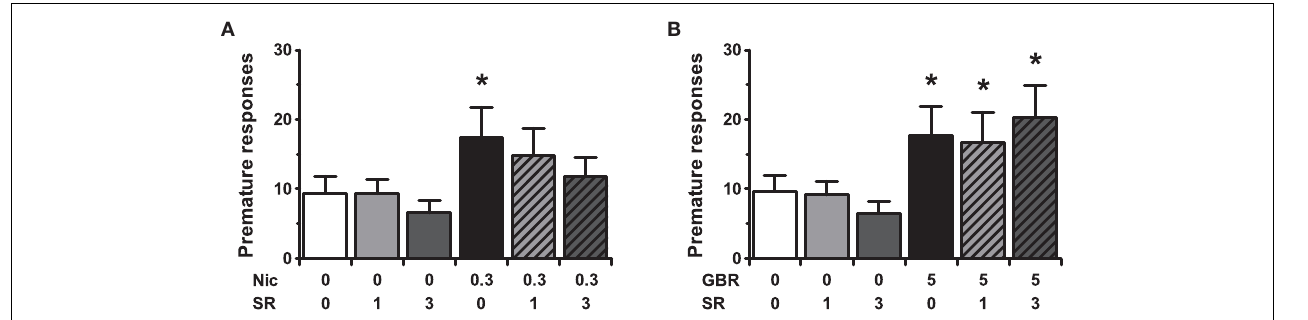
(B) ], alone and in combination with SR141716A (SR), on the mean ( ± SEM) number of premature responses made in the 5-CSRTT. In total n = 14–15 rats were included in the analyses. Drug doses are expressed as mg/kg. ∗ p < 0.05 versusVehicle–Vehicle control.